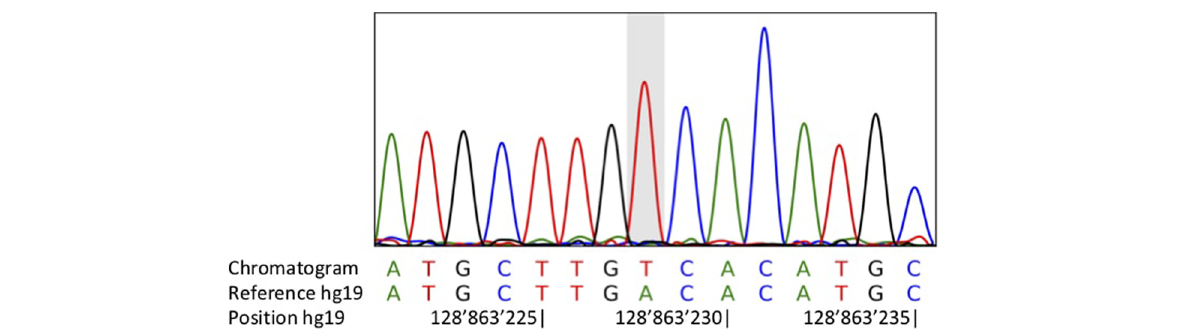
Fig. 2 Electrophoregram from Sanger sequencing of the proband showing the homozygous c.525 T > A change in exon 6 of MFSD8 , which predicts a p.Cys175Ter